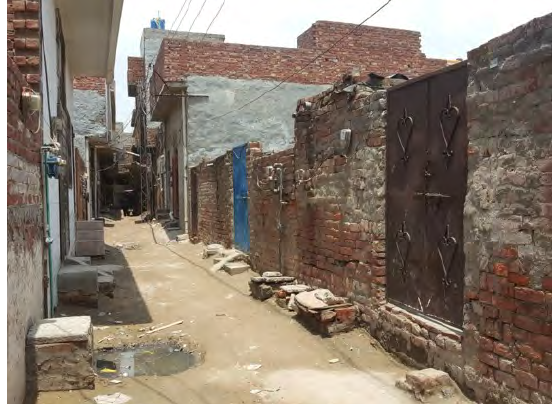
Figure 3. Alley view in Badar Colony, Source: Author